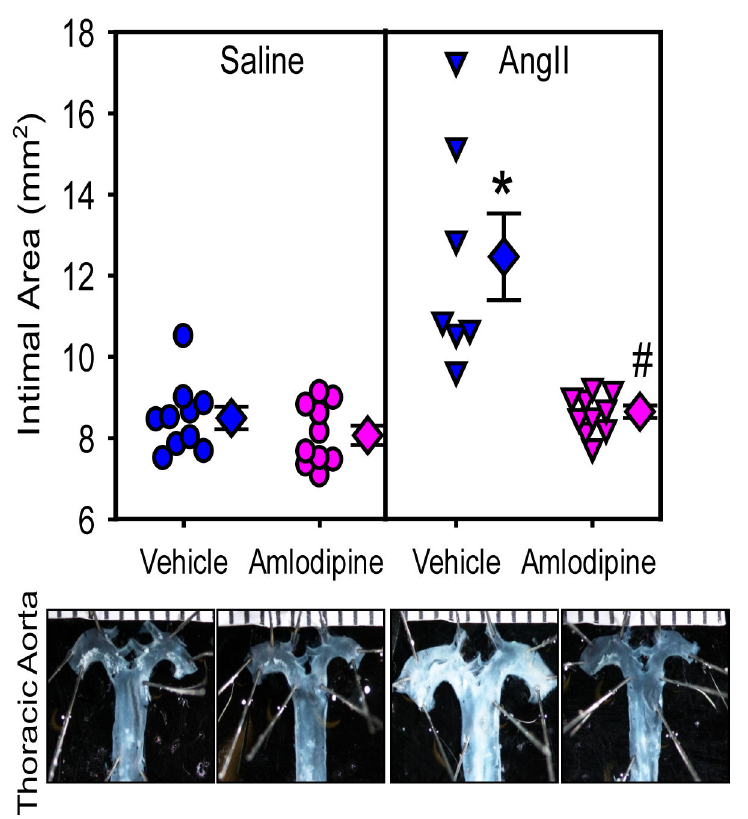
Figure 5. Amlodipine attenuated AngII-induced ascending aortic aneurysms. Ascending aortic areas were measured using an en face method. Circles and triangles are individual measurements, diamonds are means of groups, and error bars are SEMs. Representative images of aortas are shown below the graph. Statistical analyses were performed using nonparametric Kruskal- Wallis test. * denotes P=0.001 for comparison between AngII + vehicle and saline + vehicle groups, and # denotes P=0.03 for comparison between AngII + amlodipine and AngII + vehicle